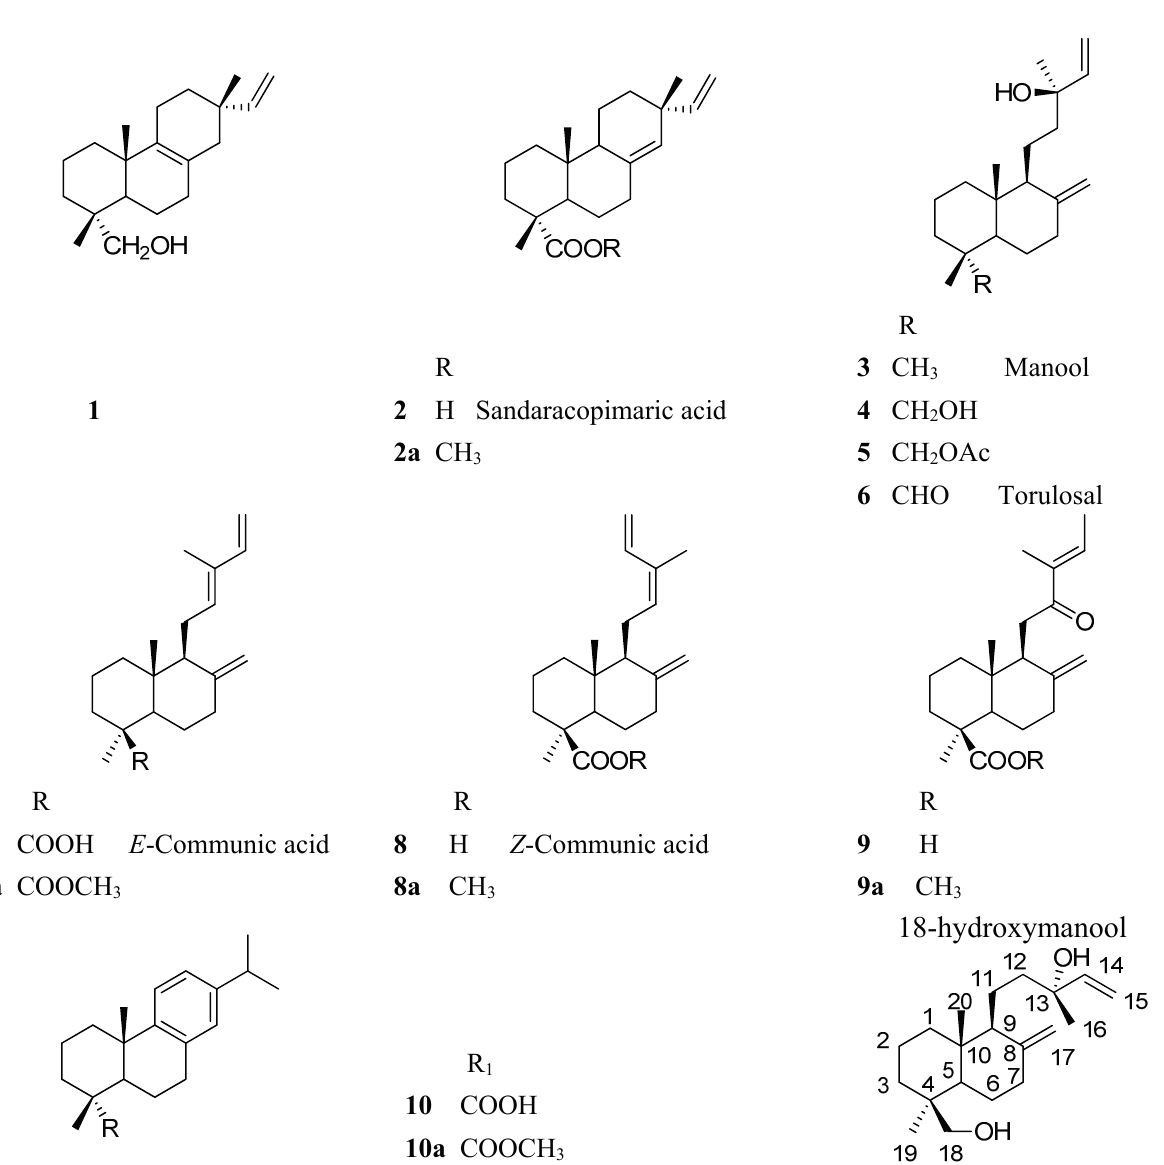
Figure 4. Structure of the compounds isolated and/or identified from the resin fractions of Austrocedrus chilensis trees naturally infected with Phytophthora austrocedri inhibiting radial growth of the phytopathogenic